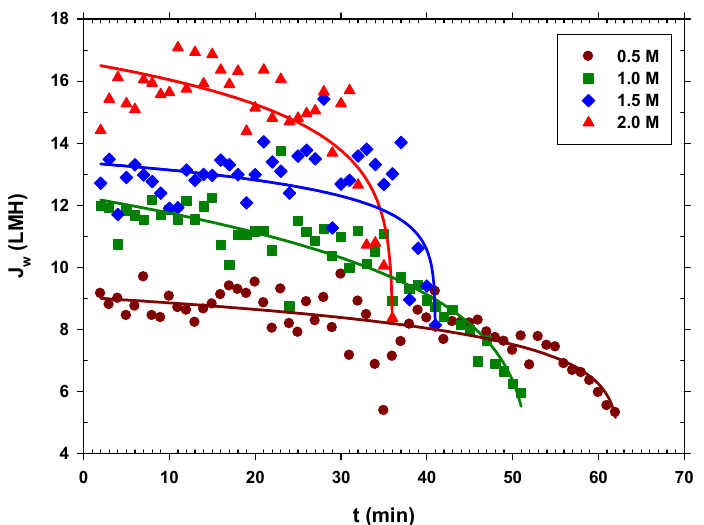
Figure 7. Water flux over time for each NaCl concentration (0.5 M, 1.0 M, 1.5 M, and 2.0 M). (Solid lines are just a visual guide to analyze trends).